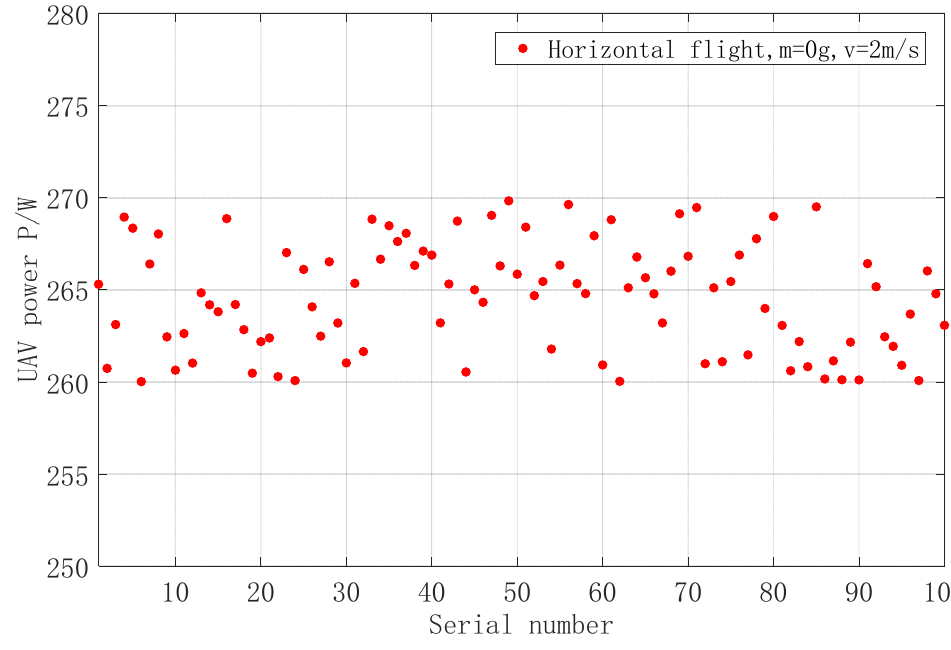
Figure 1. UAV power when no